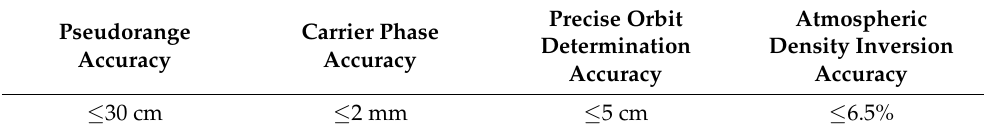
Table 1. The performances of the spherical satellite GPOD.